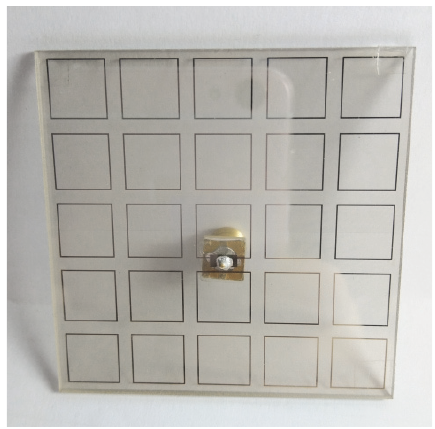
Figure 5: Overall view of the fabricated proposed antenna.